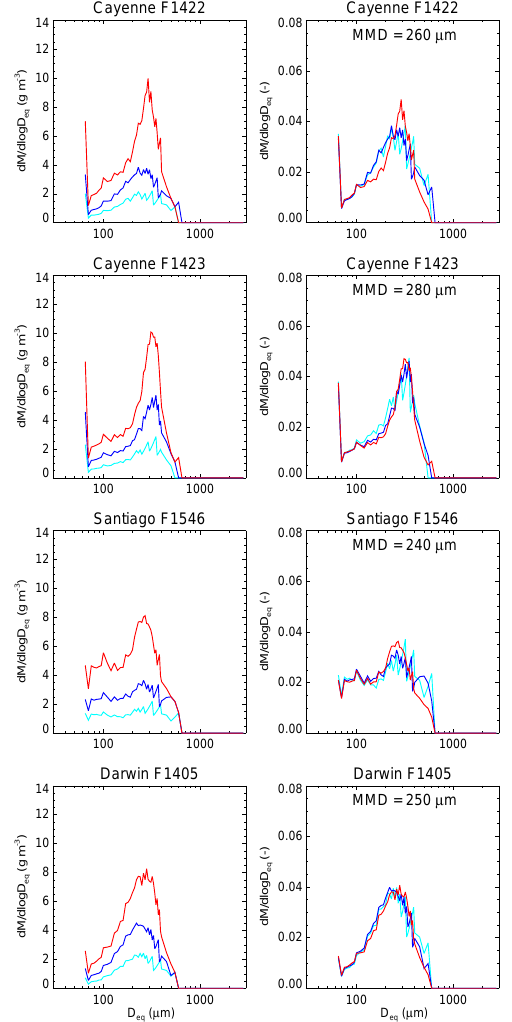
Figure 6. Ice mass size distributions in three ice water content (IWC) ranges (1–2, 2–4 and > 4gm − 3 shown in cyan, blue and red, respectively) based on bin-wise median measurements during four flights. Mass concentrations in gm − 3 (left panels) and normal- ized by IWC (right panels). Mass median area-equivalent diameter (MMD eq ) listed for the highest concentration range ( > 4gm − 3